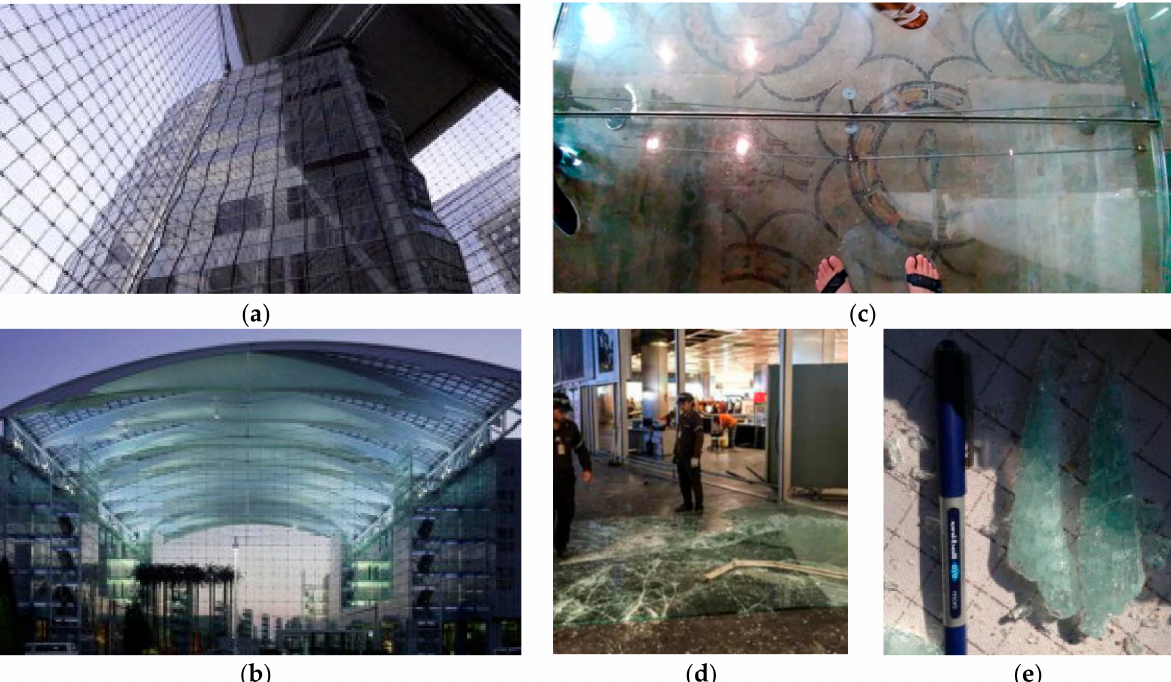
Figure 1. Examples of glass in buildings: ( a , b ) Facades and roofs for the Poly Plaza Cable-Net Wall (Beijing, CN) and the Kempinski Hotel (Munich, DE), (reprinted with permission from [24], Copyright 2021 Elsevier®, license number 5042040336444); ( c ) a pedestrian system (walkway in Aquileia, IT; reprinted from [8] under the terms and conditions of CC-BY license); ( d , e ) cracks and shards due to a hazard (reprinted with permission from [25], Copyright 2021 Elsevier®, license number